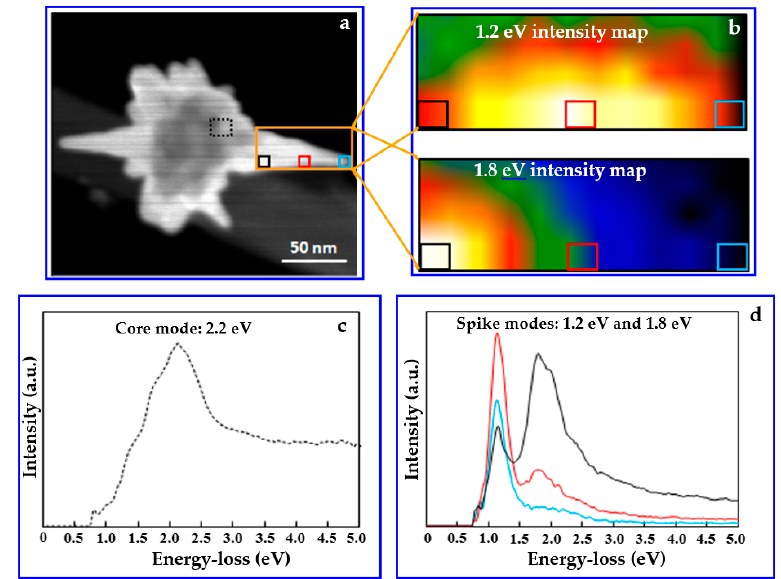
Figure 3. Electron energy loss spectroscopy (EELS) characterization of the AuNS: ( a ) AuNS image with relative areas of investigation (colored boxes); ( b ) intensity maps of major plasmonic modes at 1.2 and 1.8 eV located at the spike of the AuNS; ( c ) EELS spectra of core of the AuNS; ( d ) EELS spectra of different regions of the spike of the AuNS.